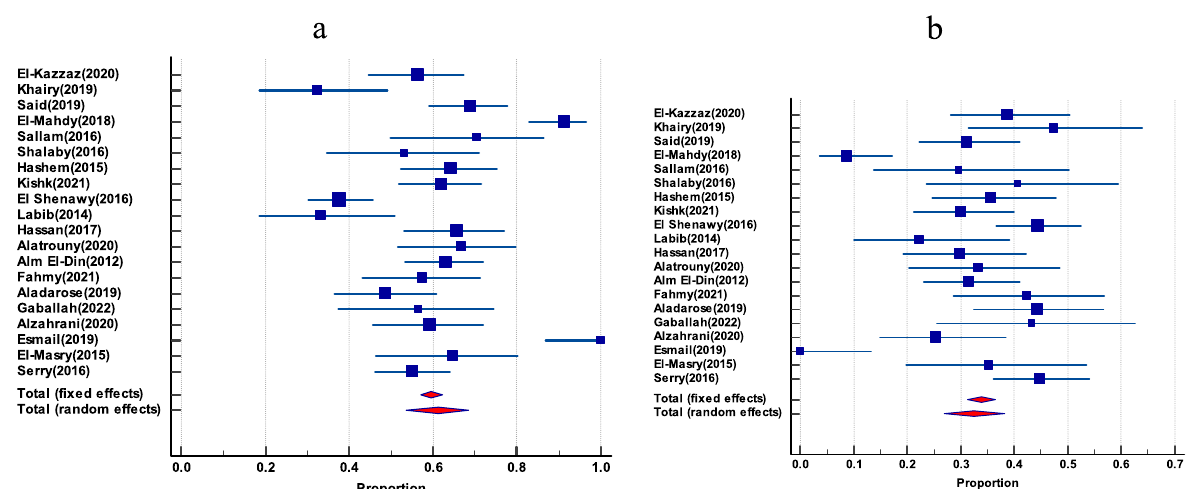
Fig. 3 The prevalence of E. faecalis and E. faecium among total enterococci isolates. a Forest plot of E. faecalis among total enterococci. b Forest plot